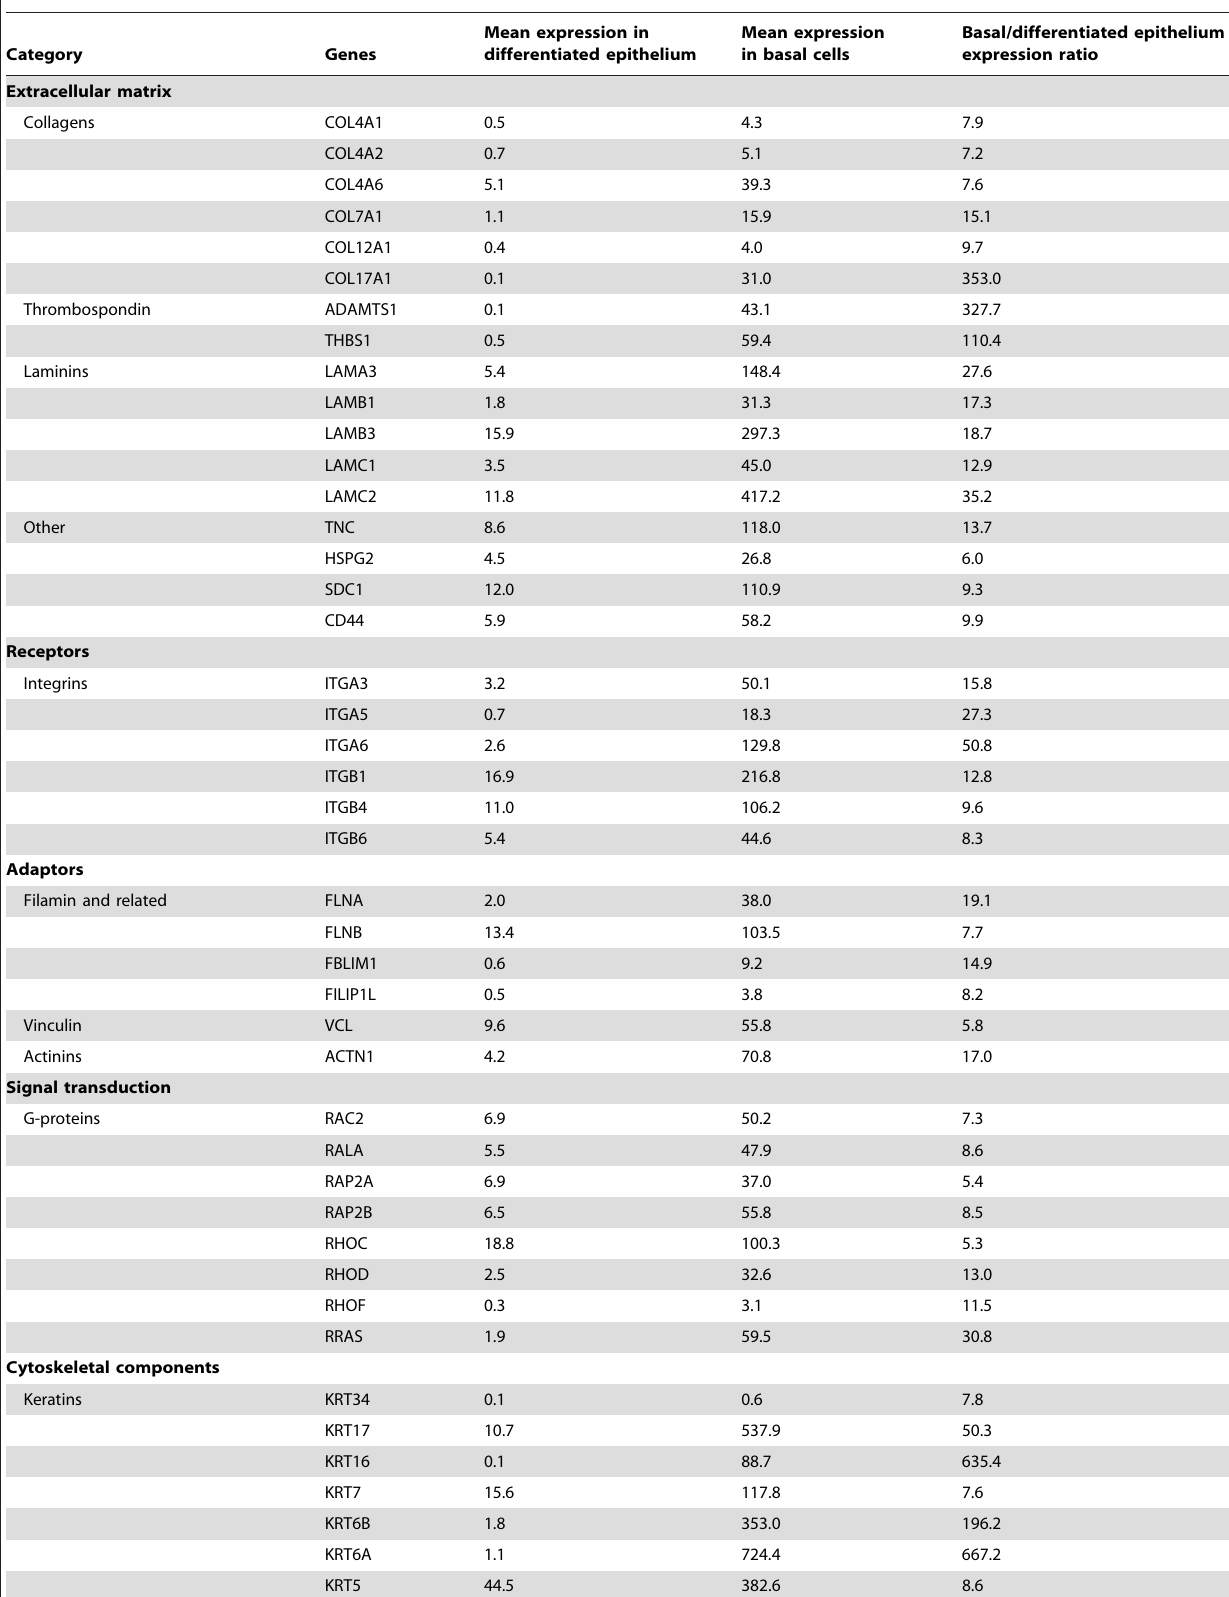
Table 5. Extracellular Matrix and Cytoplasmic Structural Proteins in the Human Airway Basal Cell-enriched Signature. 1